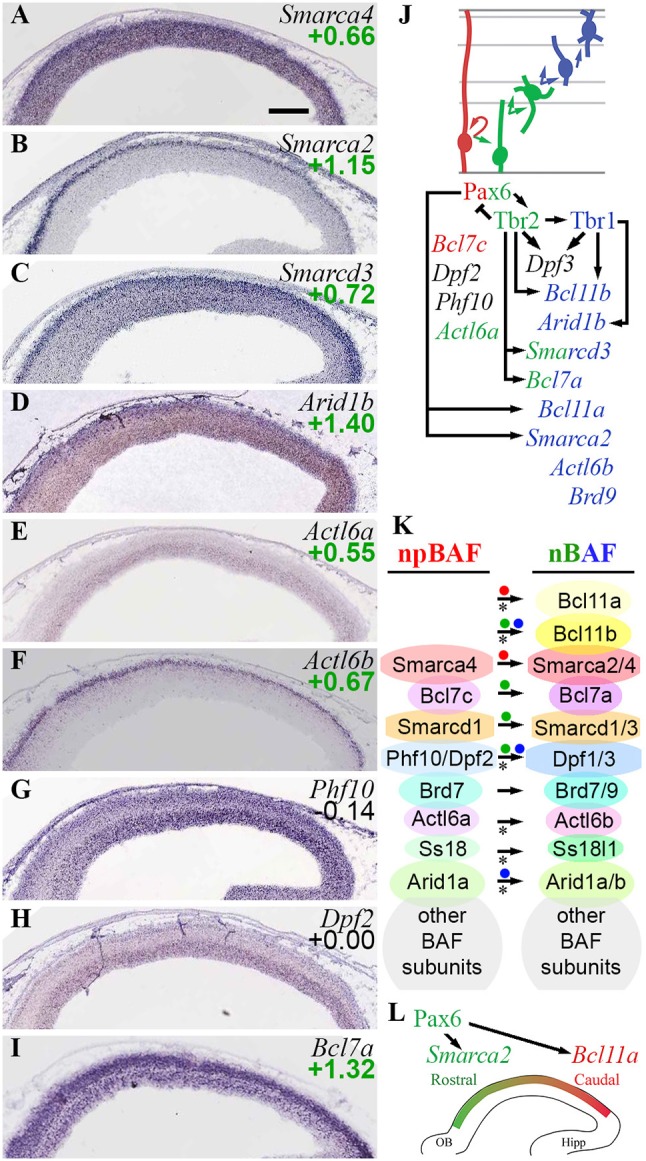
BAF chromatin remodeling complexes. (A–I) Expression of indicated genes. Remarkably, Smarca2 (Brm; B) was specifically expressed by postmitotic PNs in the CP, with a high rostral gradient. ISH: Genepaint. Scale bar: 100 μm. (J) Summary of gene expression and regulation. (K) BAF subunit switching was controlled by Pax6 (red dots), Tbr2 (green dots), and Tbr1 (blue dots). Asterisks: previously described switches in BAF subunit composition, confirmed here. (L)
Smarca2 (high rostral in CP) and Bcl11a (high caudal in IZ/CP) were both directly activated by Pax6, reflecting multiple functions of Pax6 in cortical development (see text for details).